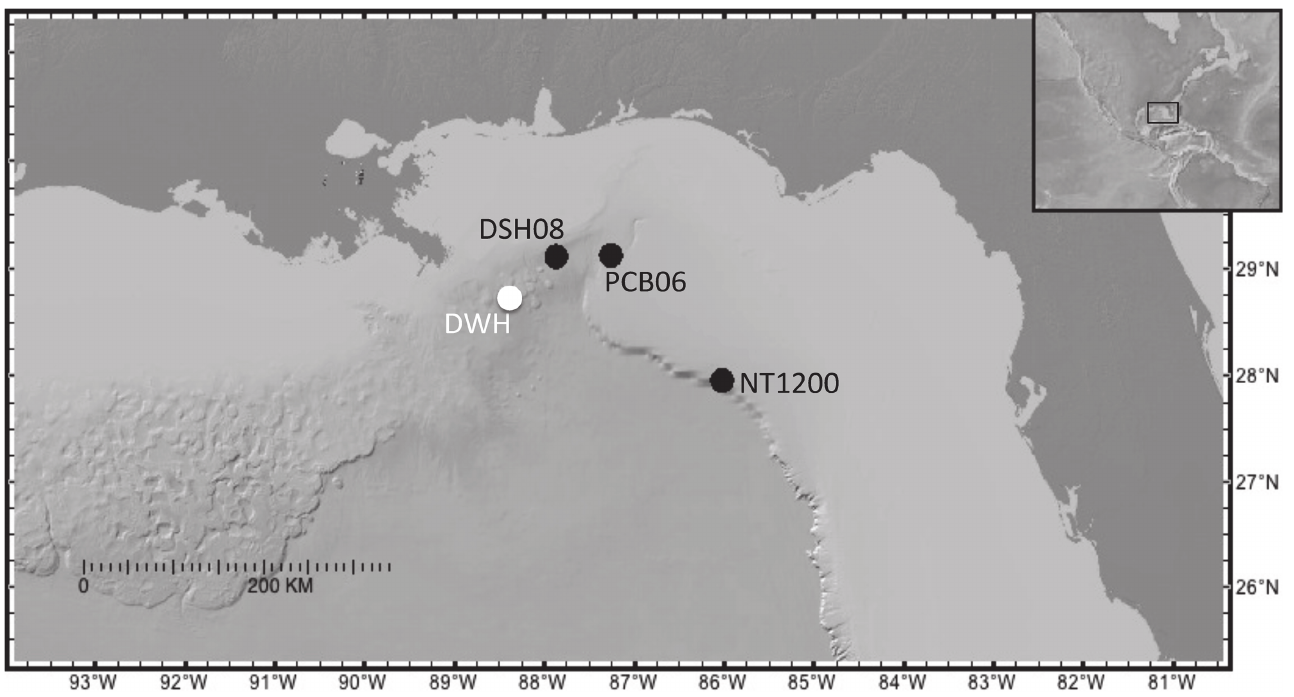
Fig 1. Location of core sampling sites in the northeastern Gulf of Mexico with reference to the Deepwater